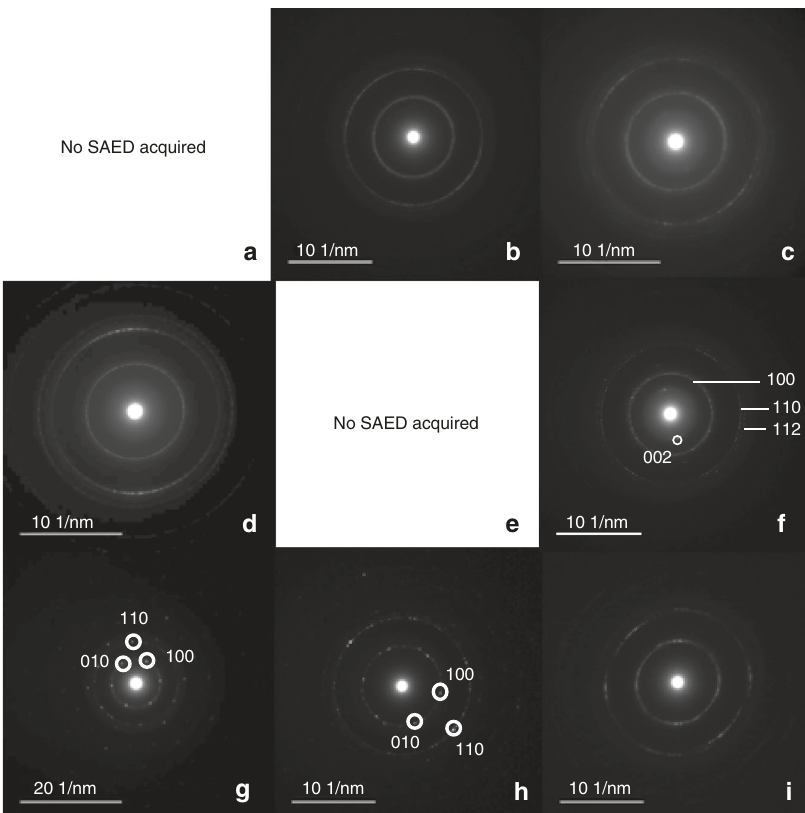
Fig. 2 Selected area electron diffraction (SAED) patterns acquired from the particles shown in Figure 1. The ring patterns generated from most particles indicate either turbostratic disorder or platy graphite layers randomly rotated and translated with respect to each other. Particles f (Biovent, 15 °C) and g and h (P Vent, 15 °C) display symmetric spot patterns that match well with graphite along [001], as shown in the